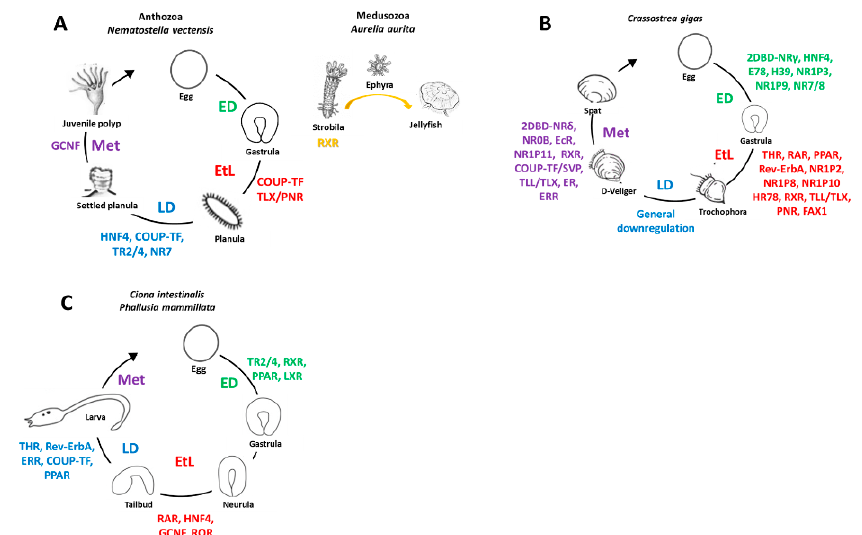
Figure 4. Nuclear receptor (NR) expression during development of marine invertebrates. ( A ) Cnidarians. ( B ) Bivalve mollusks. ( C ) Ascidian tunicates. NRs dynamically expressed during embryonic development (ED) (green), embryo to larva transition (EtL) (red), larval development (LD) (blue), metamorphosis (Met) (violet) and during cnidarian strobilation (orange). NR nomenclature is as defined in Table 1. Data for the cnidarians Nematostella vectensis and Aurelia aurita from Reitzel et al. (2009), Fuchs et al. (2014) and Brekhman et al. (2015) [30,64,65], for the bivalve mollusk Crassostrea gigas from Vogeler et al. (2016) and Huang et al. (2015; 2020) [19,24,70]. Raw data for the ascidian tunicates Ciona intestinalis and Phallusia mammillata are from the Aniseed database (https://www.aniseed.cnrs.fr/) and from Gomes et al. (2019) [53].